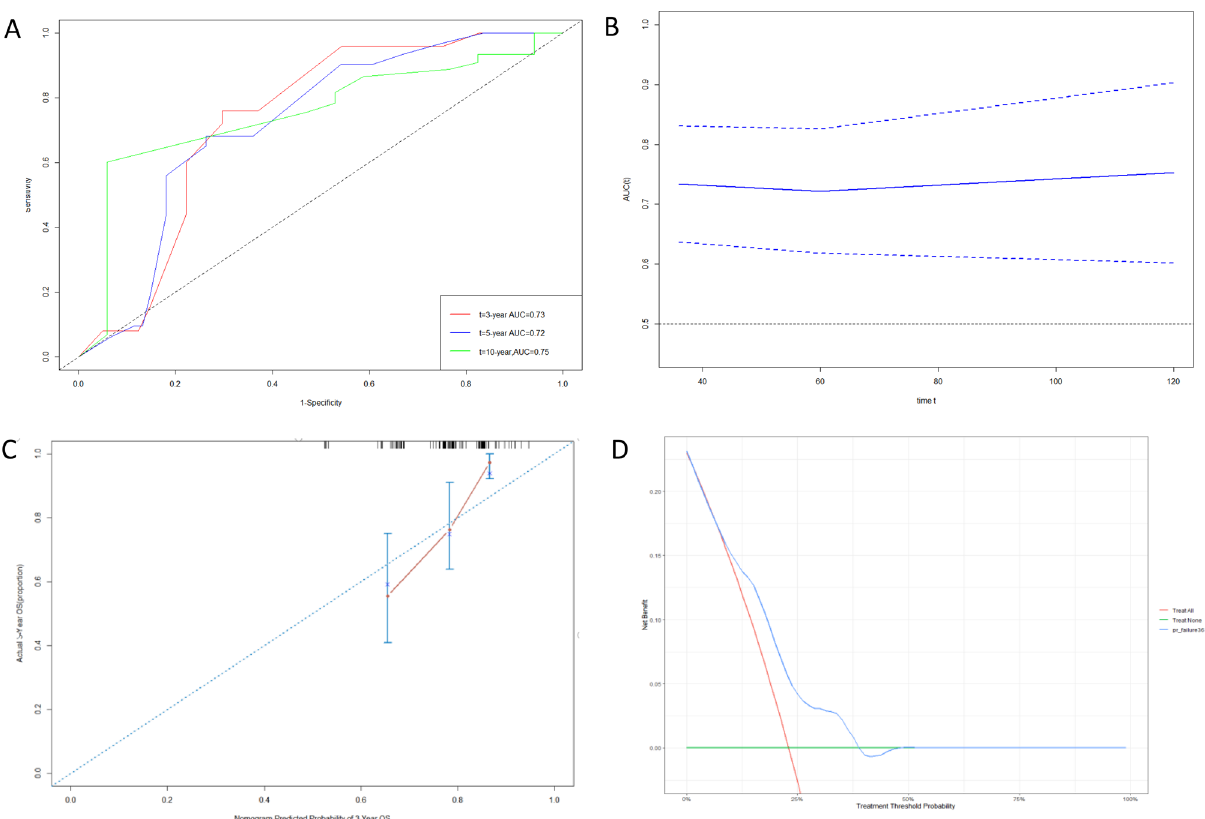
Figure 4. (A) ROC curves for 3-, 5-, and 10-year OS based on the nomogram for the validation cohort. ( B) Time-dependent AUC curve showing the performance of the nomogram in predicting OS in the validation cohort. ( C) Calibration curve of the predicted 3-year OS. ( D) Decision curve analysis for 3-year